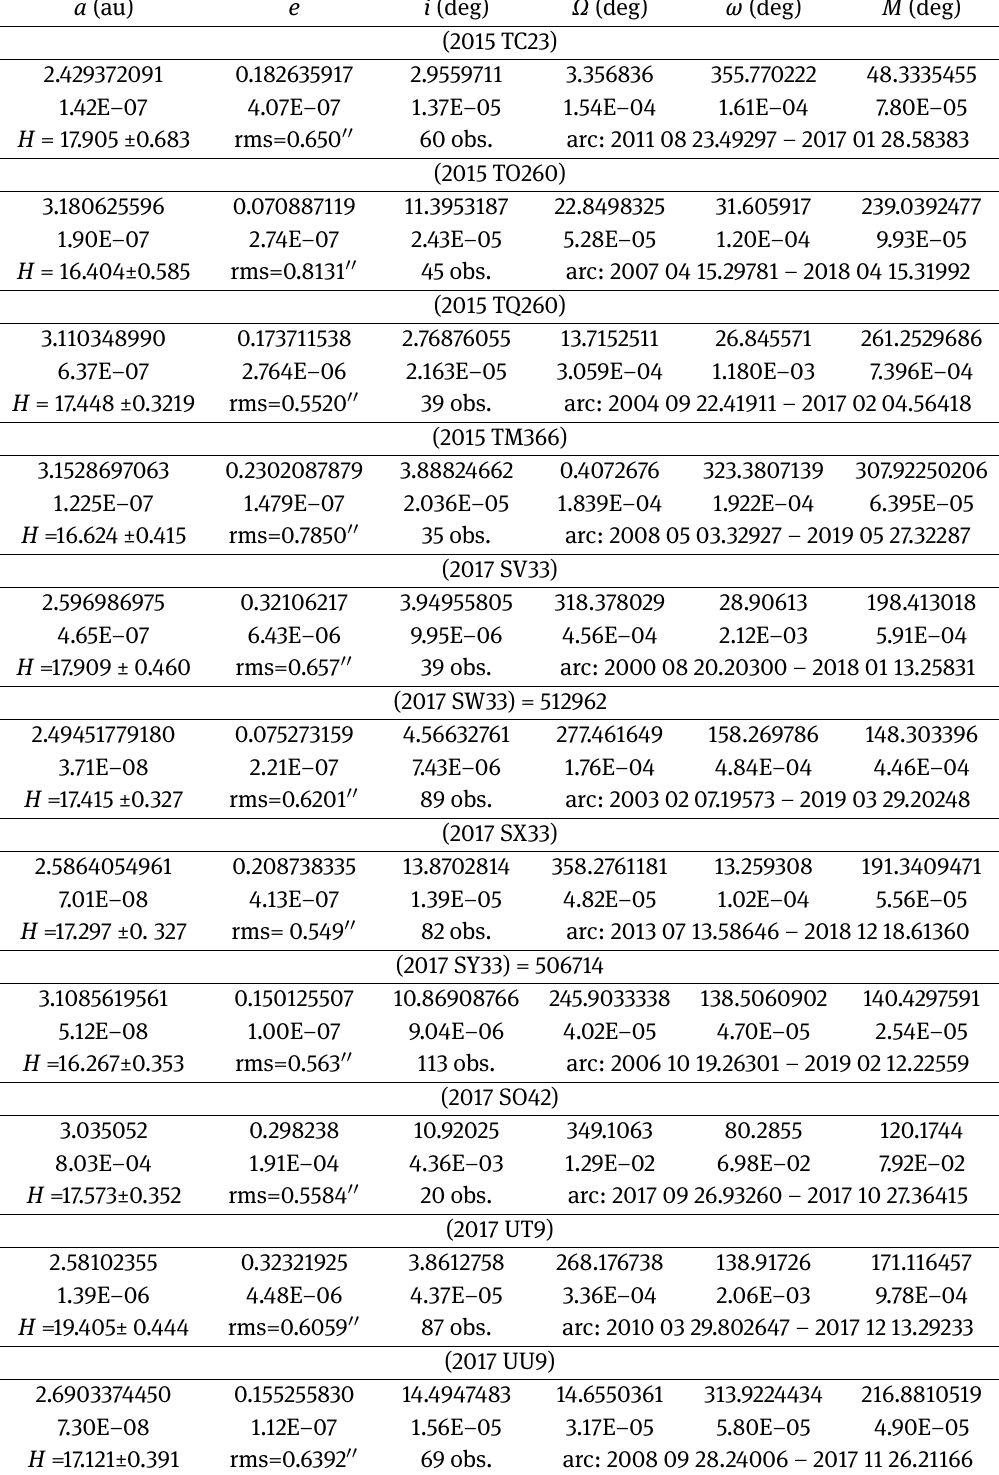
Table 3. High precision orbital elements of discovered asteroids at the Baldone Astrophysical Observatory in 2015-2018. Epoch